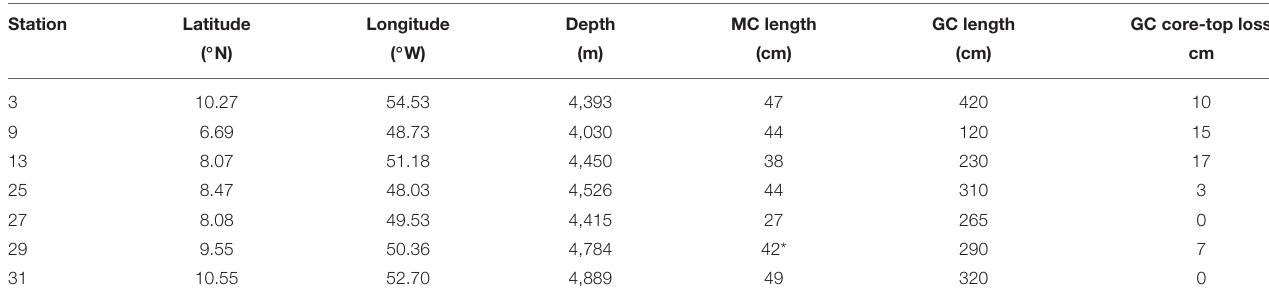
TABLE 1 | Site descriptions and lengths of Multi-Cores (MC) and Gravity Cores